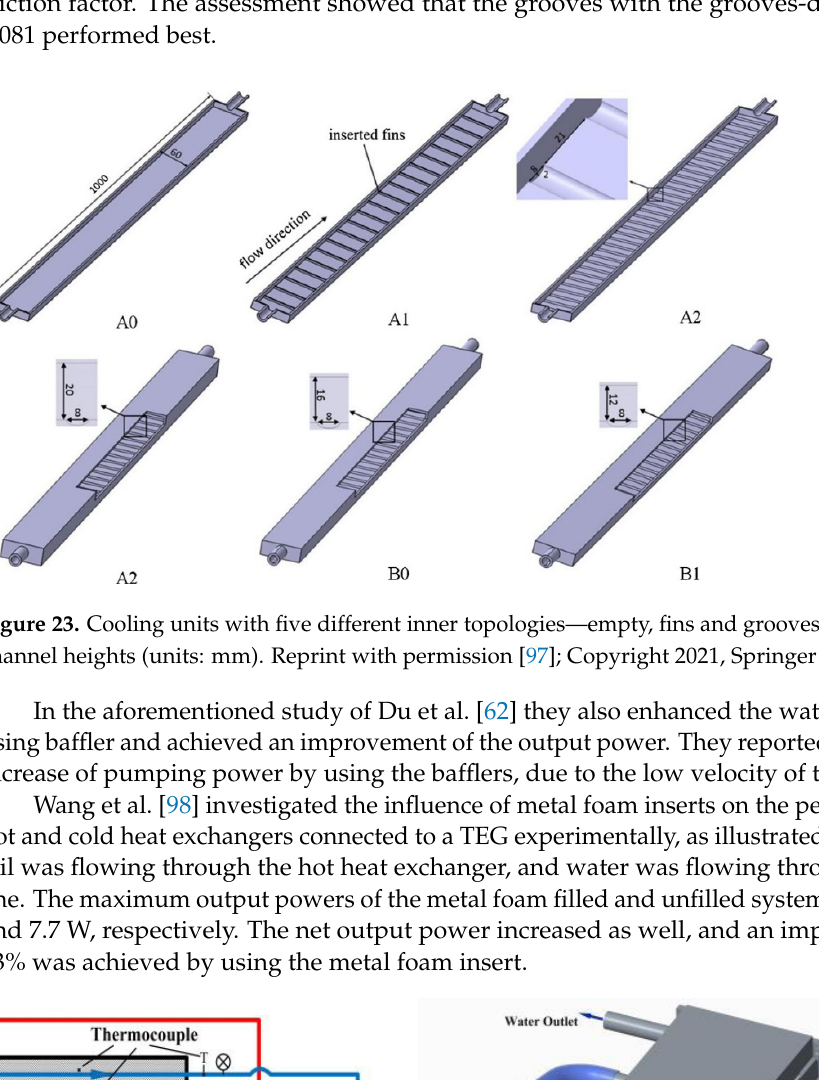
Figure 22. Experimental setup of a fluid-fluid TEG system with fins in the channels and 100 TEGs. Reprint with permission